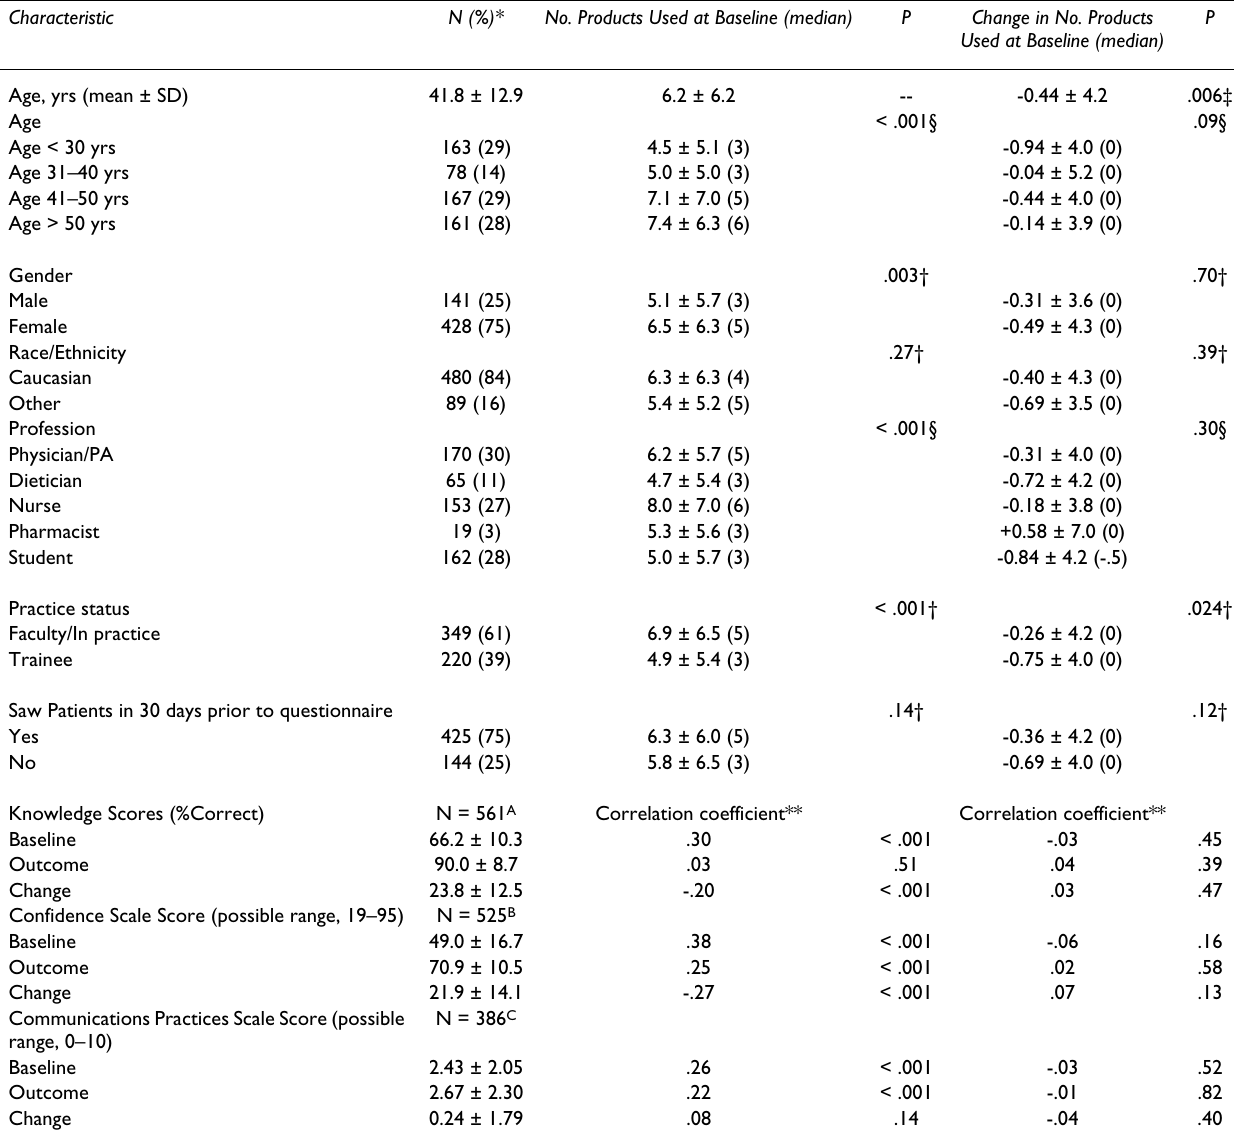
Table 1: Characteristics of and dietary supplement use among 569 health professionals at baseline (winter) and following course (spring) Characteristic N (%)* No. Products Used at Baseline (median) P Change in No. Products